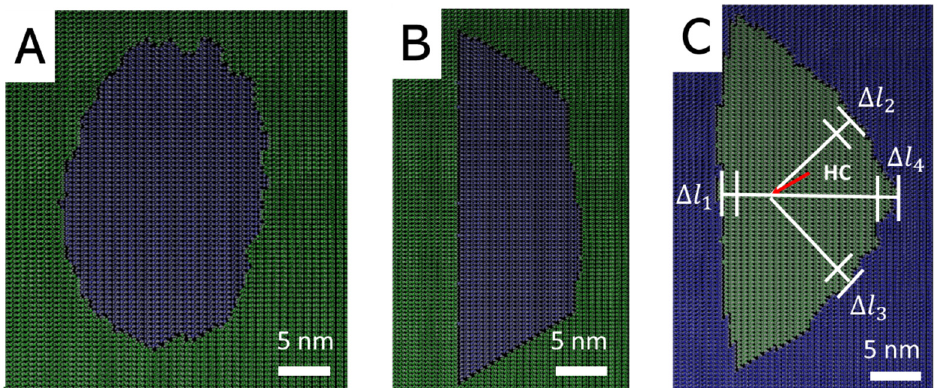
Figure 4. Morphologies of simulated monolayer pits on barite (001) face by using different parameter sets and a schematic explanation for step velocities calculations. ( A ): Parameter set I excluding Ba-O-Ba coordination sphere, ( B ): Parameter set II including Ba-O-Ba coordination sphere, ( C ): Parameter set III including steric factors 𝑤 (cid:3046)(cid:3036) . White lines here are used as auxiliary lines perpendicular to the [010], [2(cid:3364)10], and [2(cid:3364)10] -oriented atomic steps. Intersection points of those lines with step edges at two consecutive times steps were used to calculate step propagation increments ∆𝑙 (cid:3036) . The step velocities were calculated by using a simple formula: